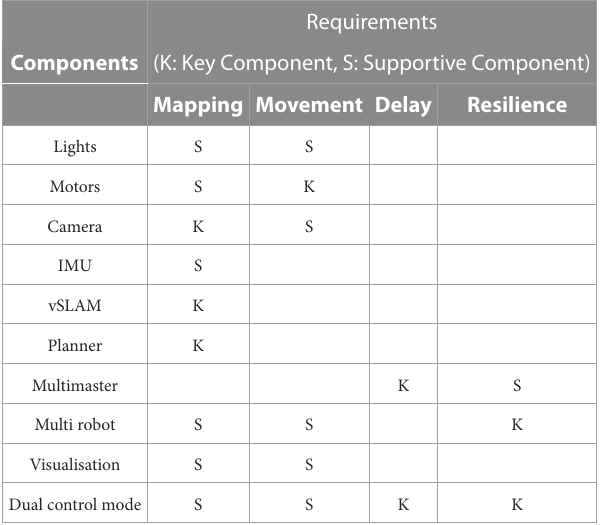
TABLE1 Componentsaddressingthesystemrequirements.